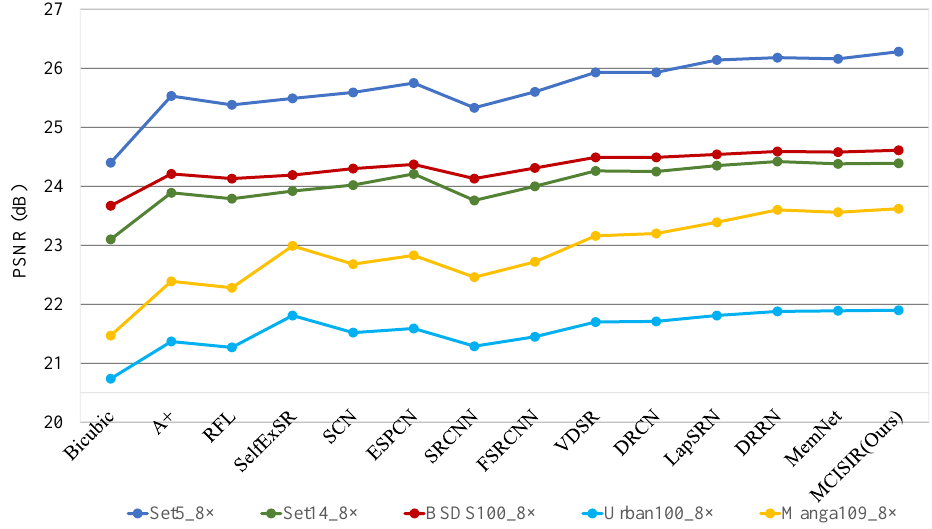
Figure 11. Peak signal to noise ratio versus different algorithms on enlargement scale factor 8 × .